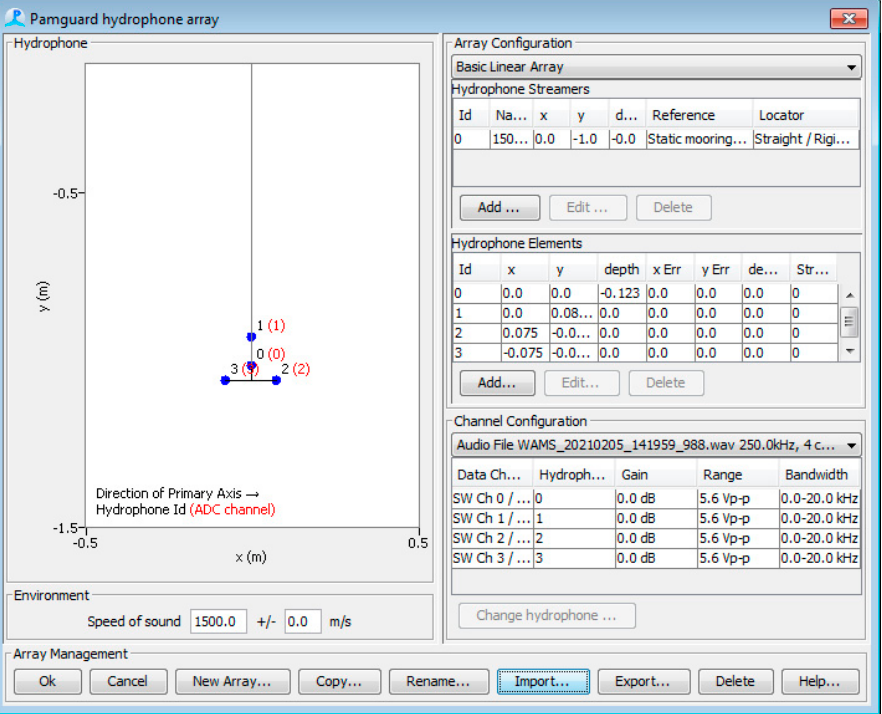
Figure 3. An example of the array manager configuration for the 4-element tetra-hedral bottom mounted hydrophone array used in the current MMP deployment.